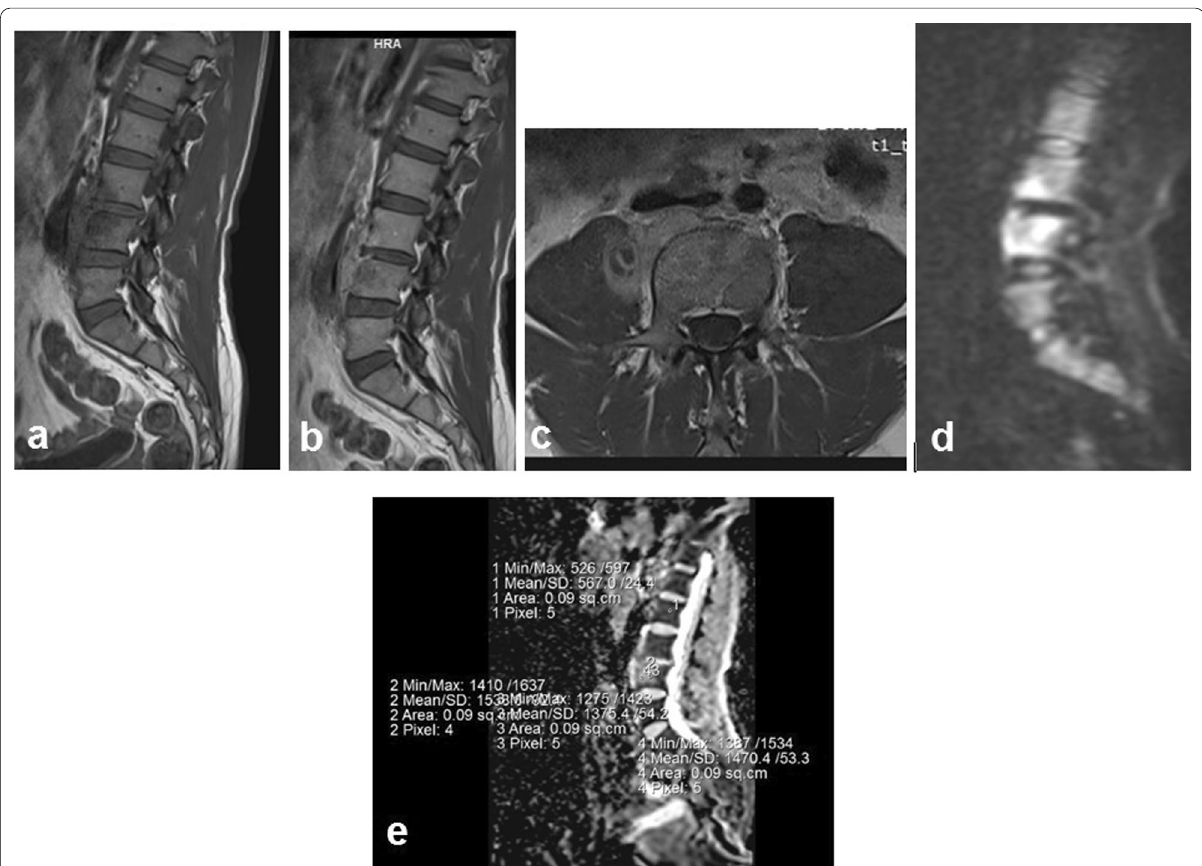
Fig. 1 a – e A 42-year-old male patient with L3-4 pyogenic spondylodiscitis. Sagittal T1 ( a ) shows L3-4 opposing end plates bone marrow edema. Sagittal T1 post-contrast ( b ) and axial T1 post-contrast ( c ) show L3-4 bone marrow, opposing end plates enhancement with prevertebral and right paravertebral enhanced soft tissue component. Sagittal DWI ( d ), ADC ( e ). DWI demonstrates diffusion restriction with bright signal intensity,